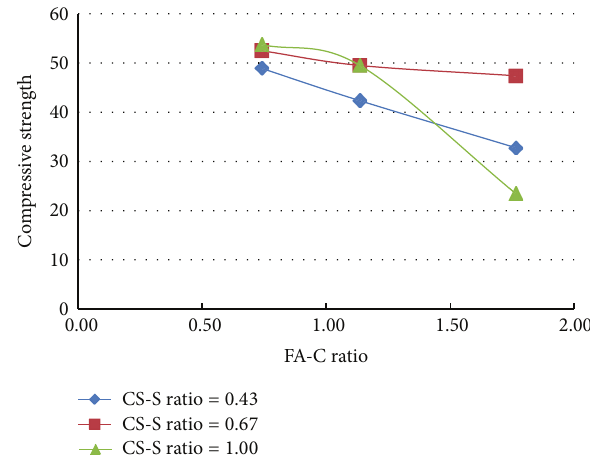
Figure1:CompressivestrengthversusFA-Cratio(specimensS1–S9: without fibres).